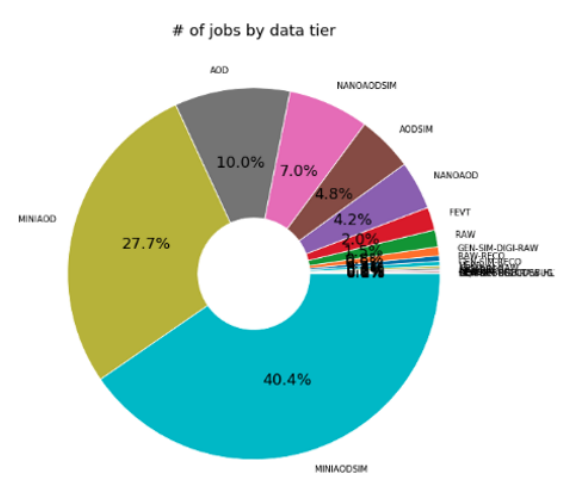
Figure 1. Distribution of Analysis Jobs in CMS in 2019. Data obtained from MONIT